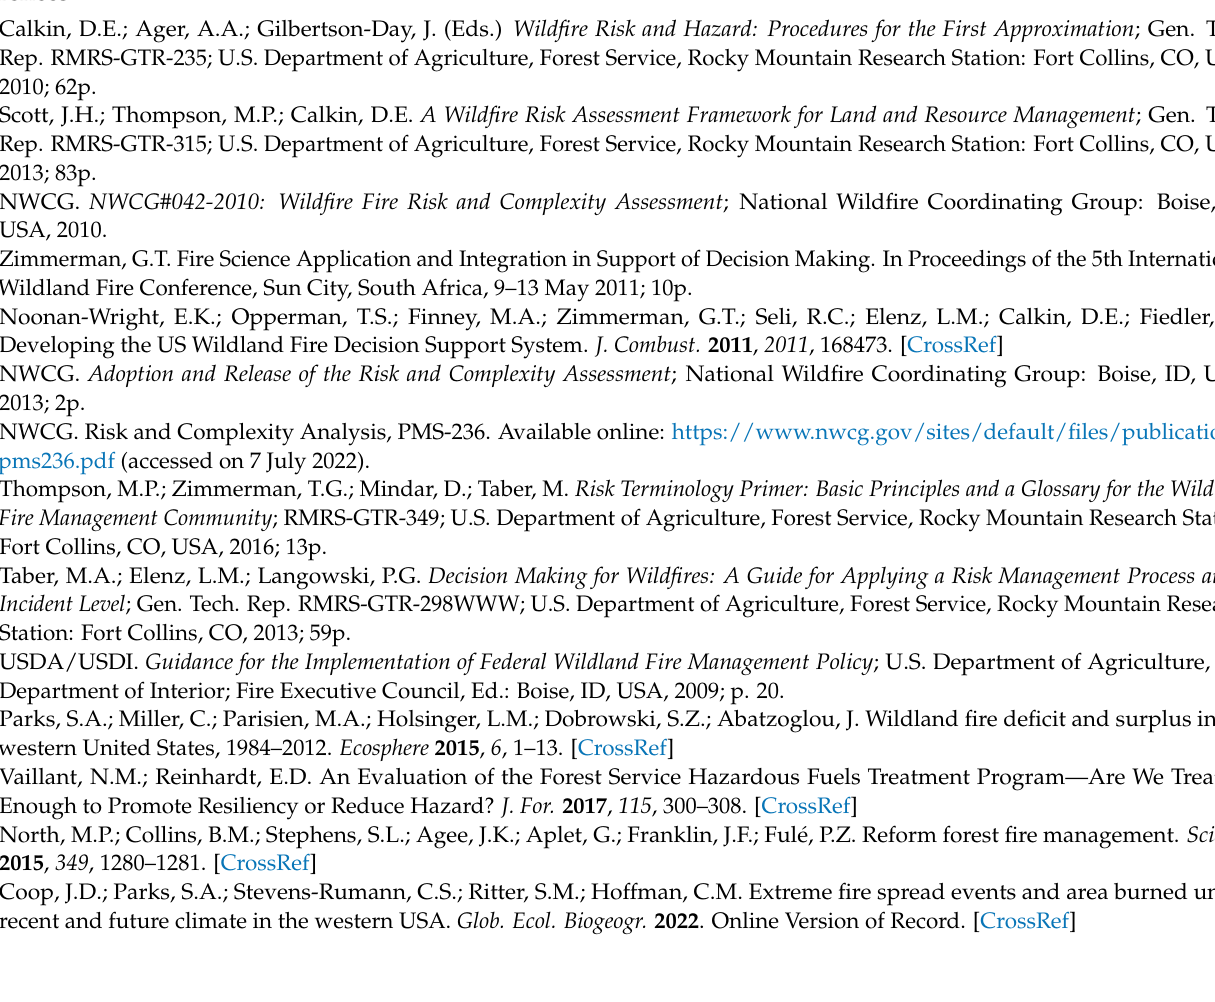
Figure A4. Southwest CART model classifying high, moderate and low relative risk.